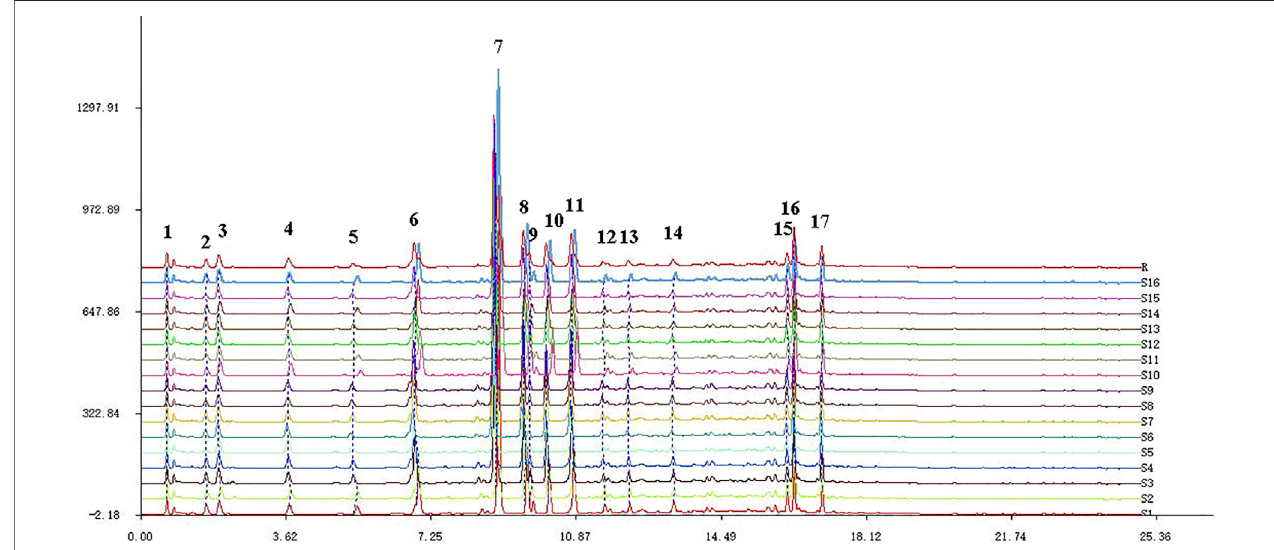
FIGURE 2 | HPLC fi ngerprints of 16 batches of XKST and reference fi ngerprint.